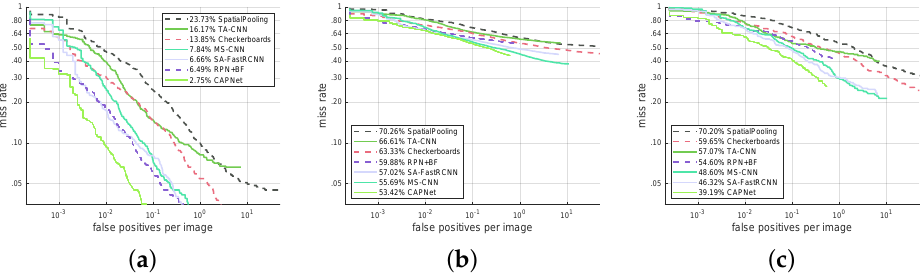
Figure 5. Comparisons of the state -of-the-art on three Caltech subsets: Reasonable, All and Occ.